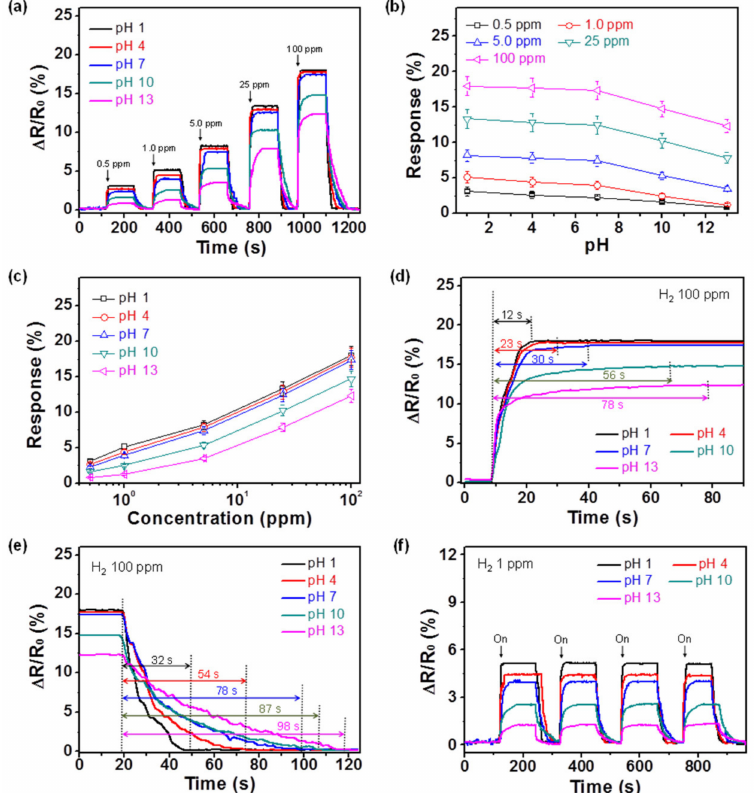
Figure 6. ( a ) The normalized resistance changes upon sequential exposure to various concentrations of hydrogen gas (black: pH 1; red: pH 4; blue: pH 7; green: pH 10; pink: pH 13). ( b ) The response changes upon sequential pH di ff erences with same hydrogen concentration (black: 0.5 ppm; red: 1 ppm; blue: 5 ppm; green: 25 ppm; pink: 100 ppm). ( c ) Calibration lines serve as a function of the hydrogen gas concentration. ( d ) The response and ( e ) recovery times of the electrodes with proton variations at 100 ppm of hydrogen gas. ( f ) The normalized resistance changes of the electrodes upon sequential periodic exposure to 1 ppm of hydrogen gas. Each pH treatment is represented by the following: black for pH 1; red for pH 4; blue for pH 7; green for pH 10; and pink for pH 13,